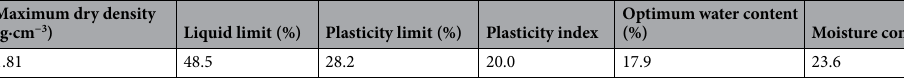
Table 2. Physical properties of tested net-like red